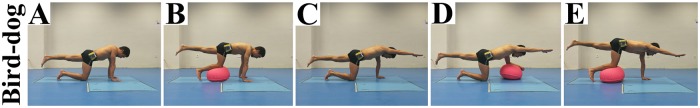
Variations of the bird-dog exercise.A) three-point position with an elevated leg; B) three-point position with an elevated leg and the contralateral knee on an unstable surface; C) classic two-point bird-dog position with elevated contralateral leg and arm; D) two-point bird-dog position with the forearm on an unstable surface; E) two-point bird-dog position with the knee on an unstable surface. The depicted individual is the first author. The individuals in this manuscript have given written informed consent (as outlined in PLOS consent form) to publish these case details.